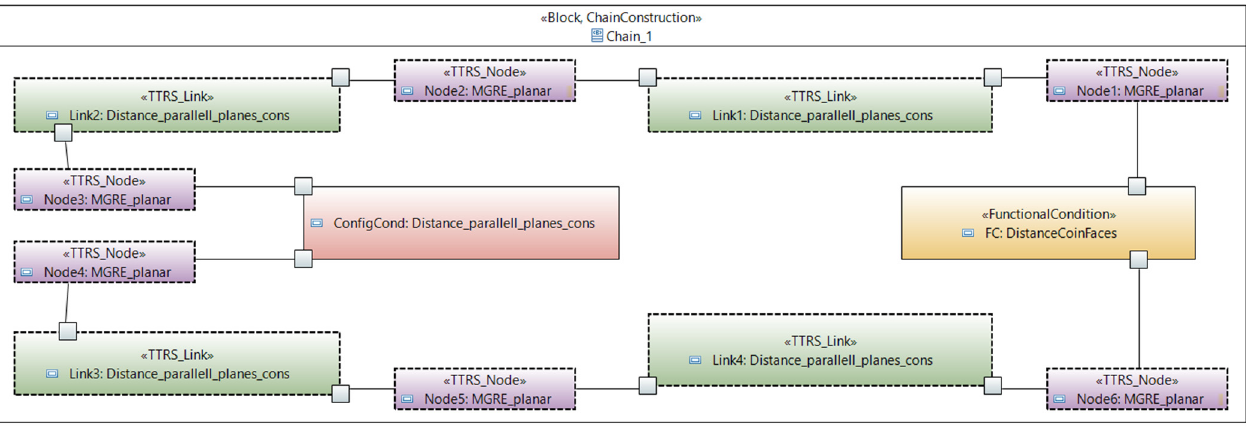
Figure 22. IBD of the Chain_1 Block.